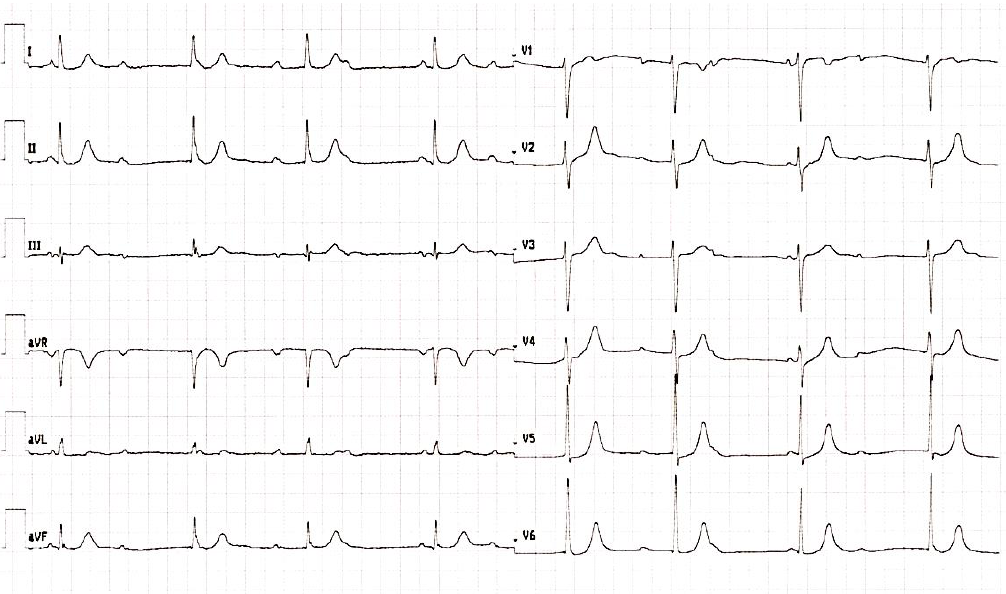
Figure 1. ECG taken at the cardiology department showing the complete heart block.